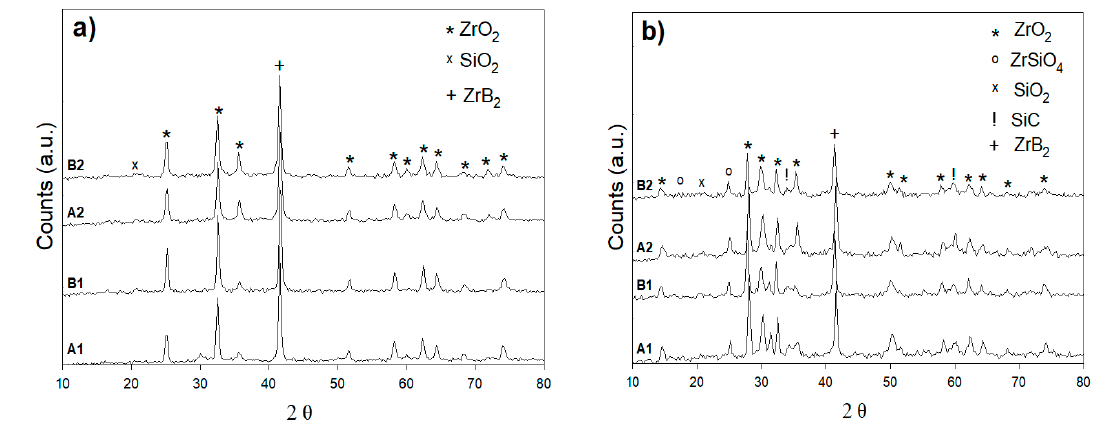
Figure 9. XRD patterns of the surface oxidation of A1, B1, A2, and B2 of ( a ) torch treatment for 5 min at 800 °C and ( b ) furnace treatment for 30 min at 800 °C.